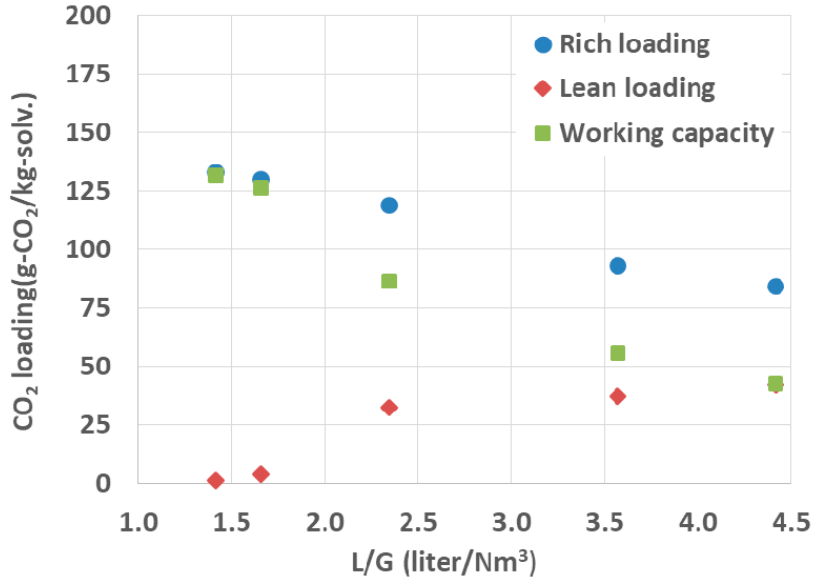
Figure 5. Rich/lean loading and working capacity results depending on L/G for IAP .